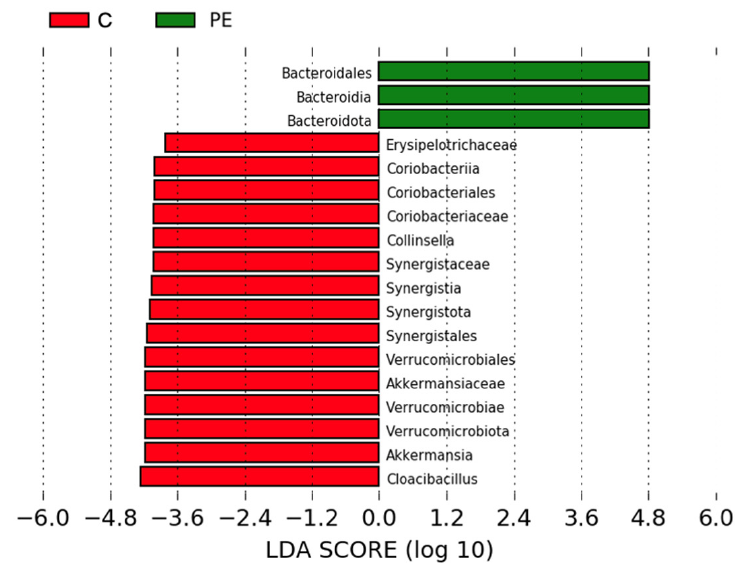
Figure 4. Linear discriminant analysis effect size (LEfSe) analysis showing significantly differential relative abundances of bacteria in control and PE pregnancies at all taxonomic levels. LDA score threshold = 3. Green = higher in PE, red = higher in controls. Results with p values < 0.05 were considered significant and are shown in the figure.